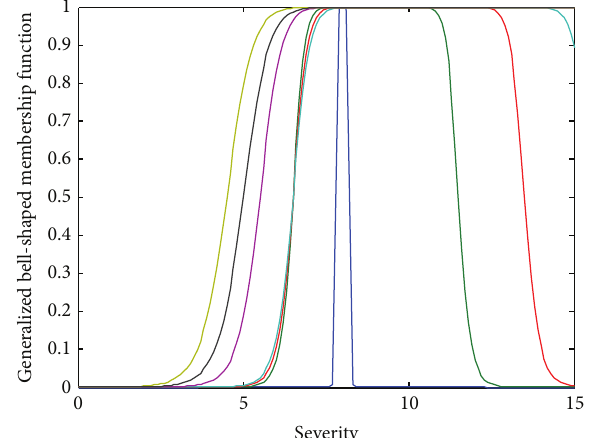
Figure 2: Generalized bell-shaped membership function for Sever-